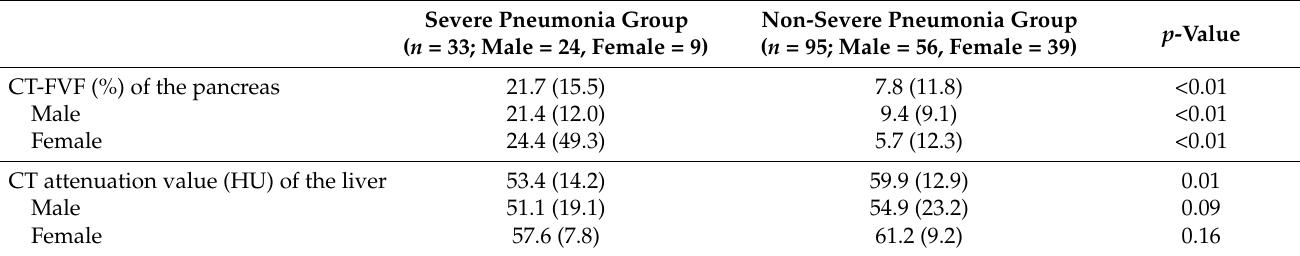
Table 1. Comparison of CT-FVF (%) of the pancreas and CT attenuation value (HU) of the liver between the severe and non-severe pneumonia groups.